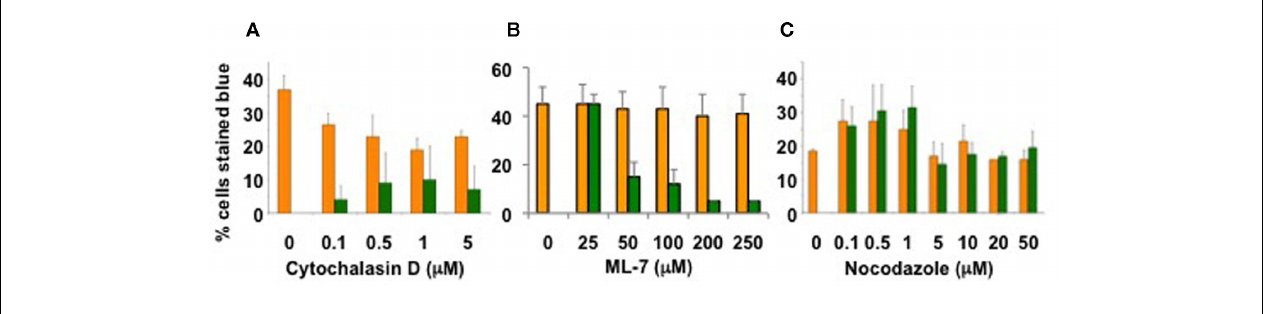
DMSO solvent, prior to infection by A. tumefaciens At849 at a ratio of 1000 bacteria/plant cell. After 48h, the cells were washed and stained for GUS activity with X-gluc. Orange bars, solvent treatment; green bars, chemical treatment. Data courtesy of Dr. Praveen